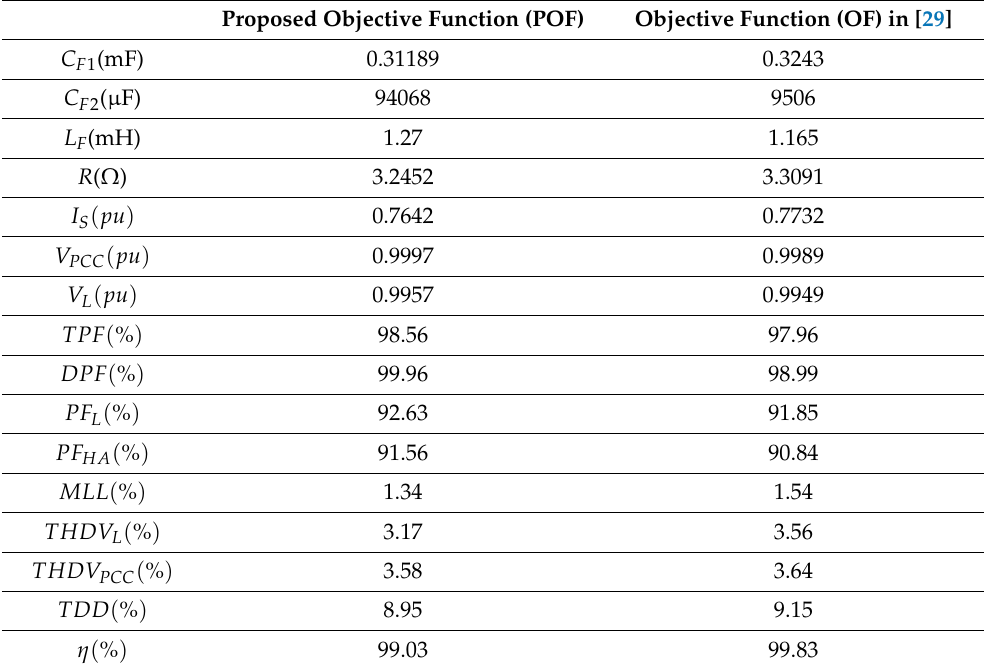
Table 6. Comparison of the POF and the represented OF in [29], based on the AOA. Proposed Objective Function